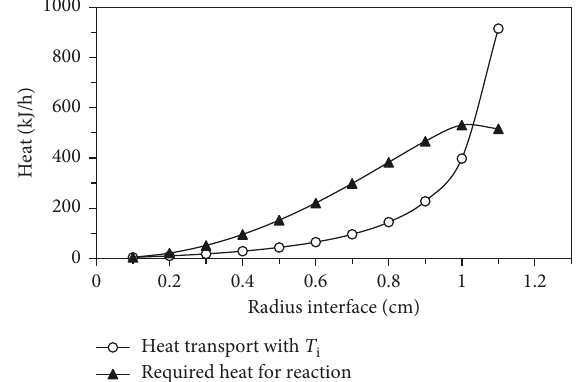
Figure 6: Calculation of heat required for reaction and heat transfer to interface as a function of interface radius ( r i ) during